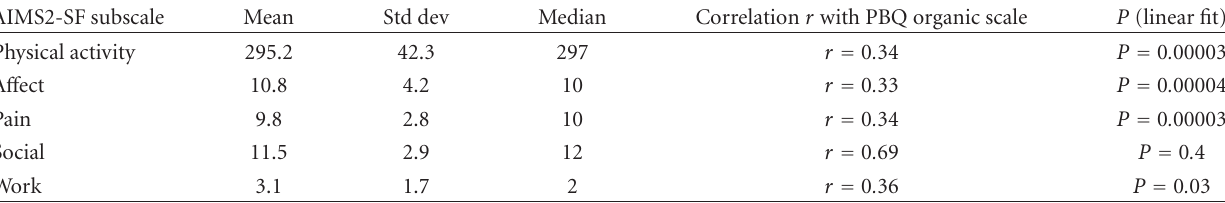
Table 3: Second-order AIMS2-SF scales and correlation with PBQ organic scale.